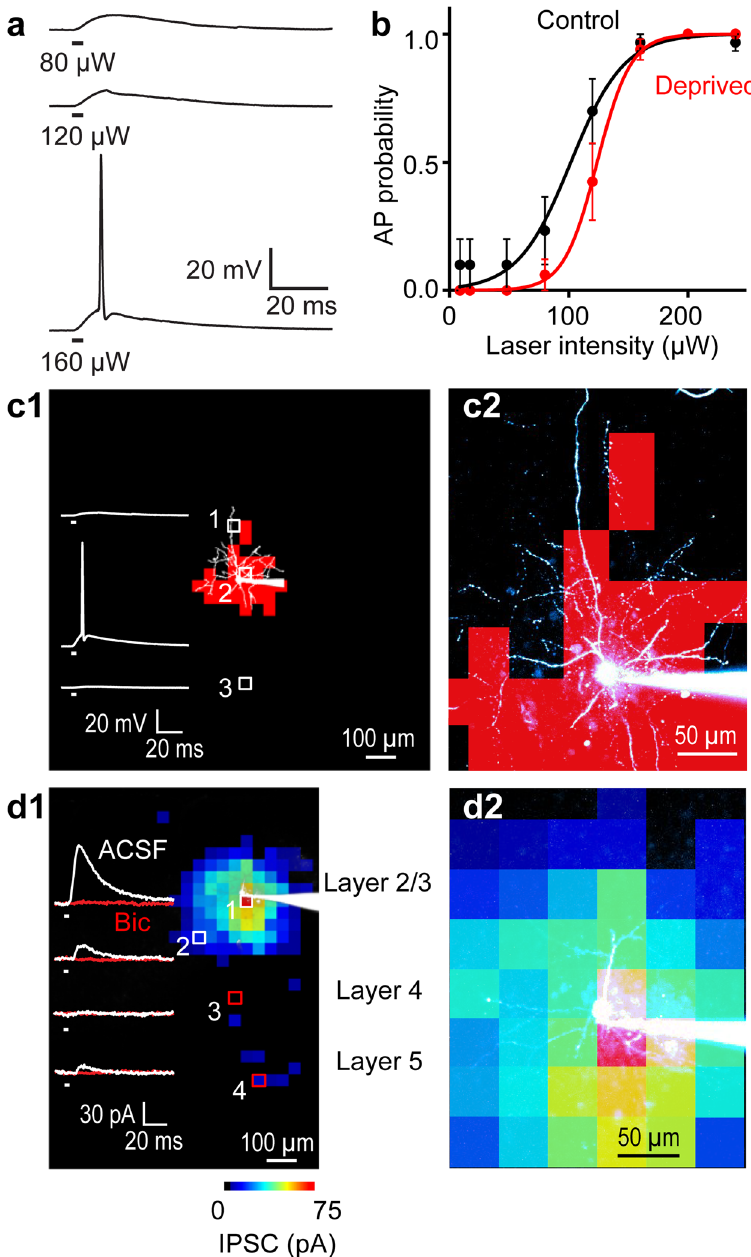
Figure 2. Parvalbumin-expressing interneurons can be reliably photostimulated. ( a ) Responses elicited in a PV cell interneuron by somatic photostimulation at different light intensities. Duration of photostimulation indicated by black bars under traces. ( b ) A cumulative probability histogram showing that 160 µ W laser power was sufficient to reliably photostimulate ChR2-expressing PV interneurons. Error bars represent s.e.m. (c1) Left – Spatially resolved photostimulation of a PV interneuron (shown in white image). Traces illustrate voltage responses to numbered locations in interneuron image. Light spots near the cell body elicited action potentials (2), but not in locations at the ends of the proximal dendrites (1) or in another layer (3). Red pixels in interneuron image indicate laser locations that evoked action potentials (optical footprint). (c2) Right - Magnified version of left image, more clearly showing the position of the PV interneuron in the optical footprint map. ( d ) Mapping of inhibitory inputs onto postsynaptic layer 2/3 pyramidal neurons, with current traces shown on the left. (d1) Left - Inhibitory responses (white traces) were blocked by bicuculline (red traces). Map of spatial distribution of IPSCs is superimposed on image of pyramidal neuron, with IPSC amplitude encoded in pseudocolor scale shown below. (d2) Right - Magnified version of map and pyramidal cell image shows the relationship of inhibitory inputs to the pyramidal neuron. Strongest IPSC responses were evoked near the pyramidal cell